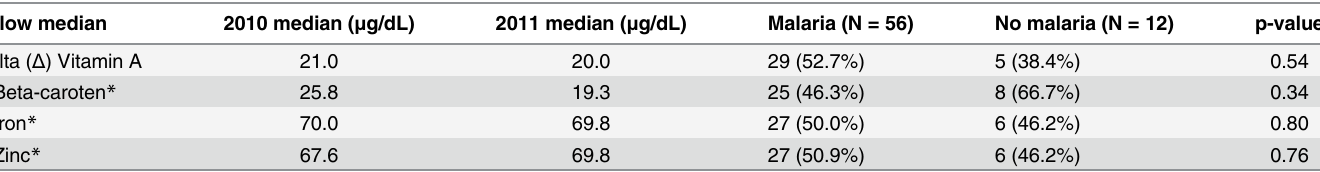
Table 3. Association between malaria during the observation period (May 2010 – May 2011) and less than median micronutrient serum levels during the same period. Below